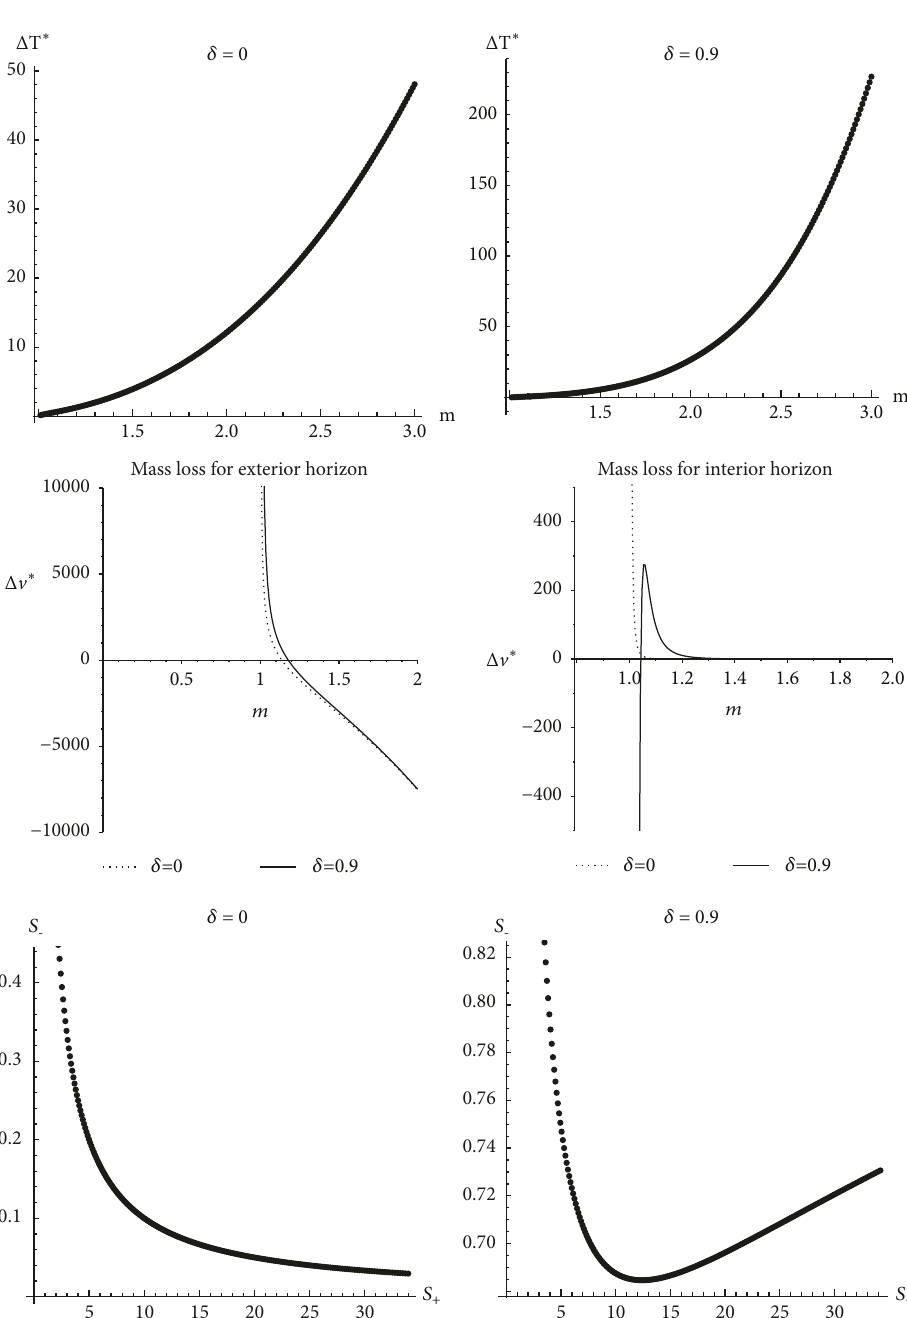
The latter behavior shows changing the sign of first derivative of 𝐺 ∗ + when decreases 𝑚 and/or Δ𝑇 ∗ which means that the phase transition is first